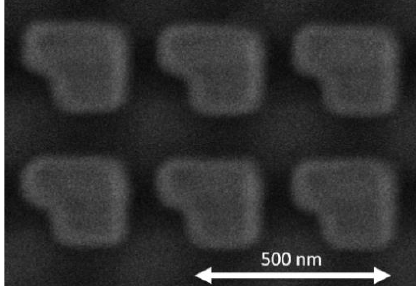
Fig. 1. Top-view SEM image of a fabricated broken- symmetry TiO 2